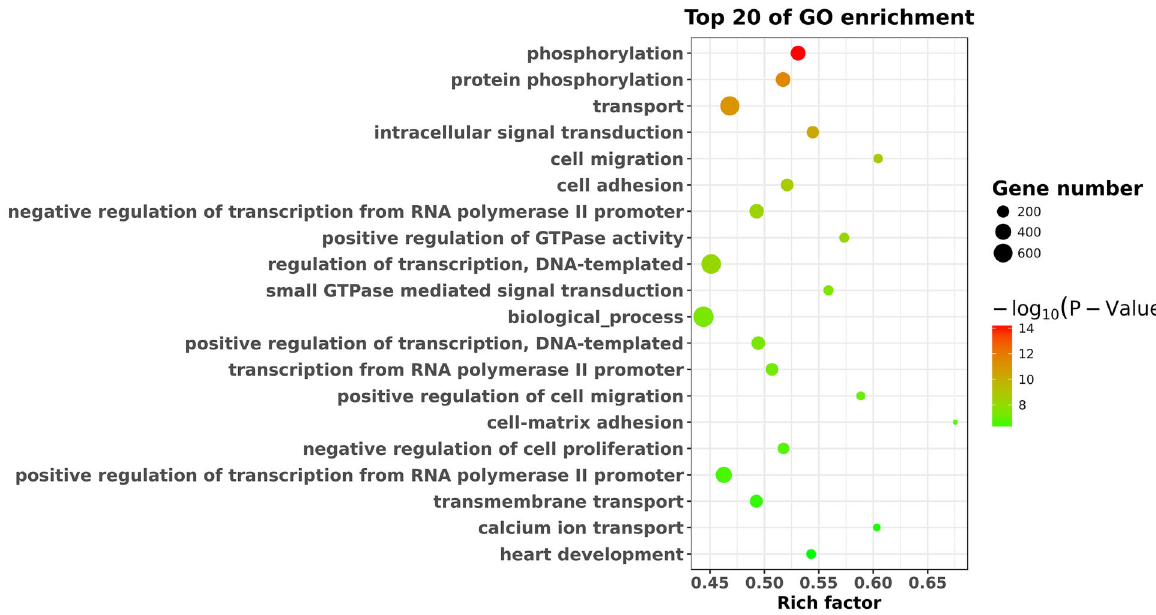
Figure 3. Functional enrichment analyses of the target genes of the differentially expressed miRNAs using Gene Ontology (GO) enrichment analysis. The top 20 biological processes are shown. Braz J Med Biol Res | doi: